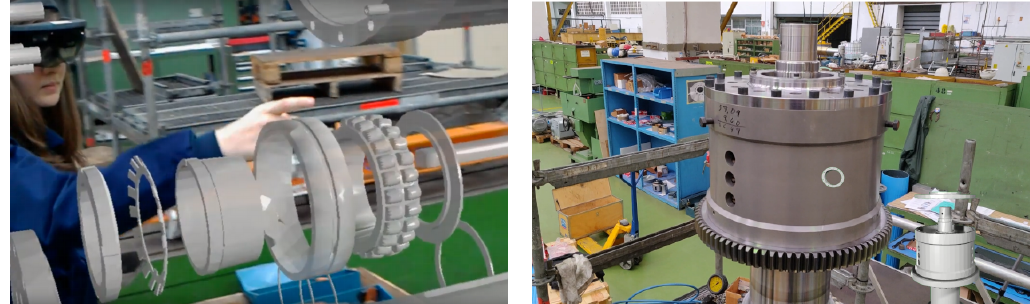
Figure 12. Interaction between two devices with a shared 3D element ( left ) and the assembly process at Navantia’s Turbine workshop ( right ).